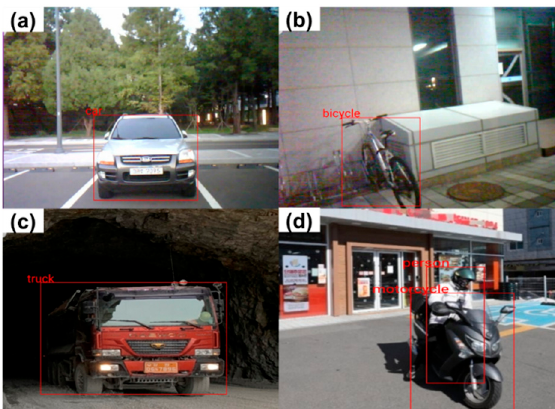
Figure 11. Hazardous object recognition screen in the AI smart helmet PWS app. ( a ) Car; ( b ) Bicycle; ( c ) Truck; ( d ) Motorcycle with